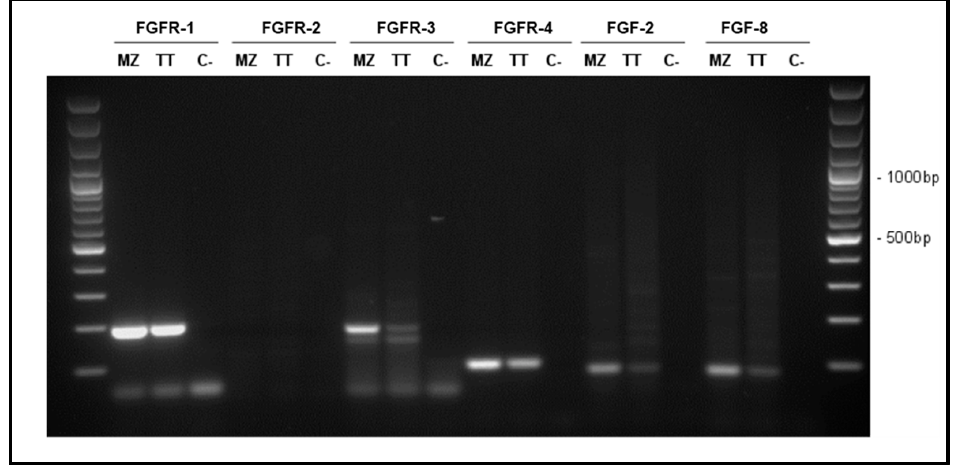
Figure 1. Representative results of FGFR-1 (192 bp), FGFR-2 (144 bp), FGFR-3 (181 bp), FGFR-4 (94 bp), FGF-2 (83 bp) and FGF-8 (82 bp) mRNA expression in TT and MZ-CRC-1 cells (MZ). Water was used as negative control (C).